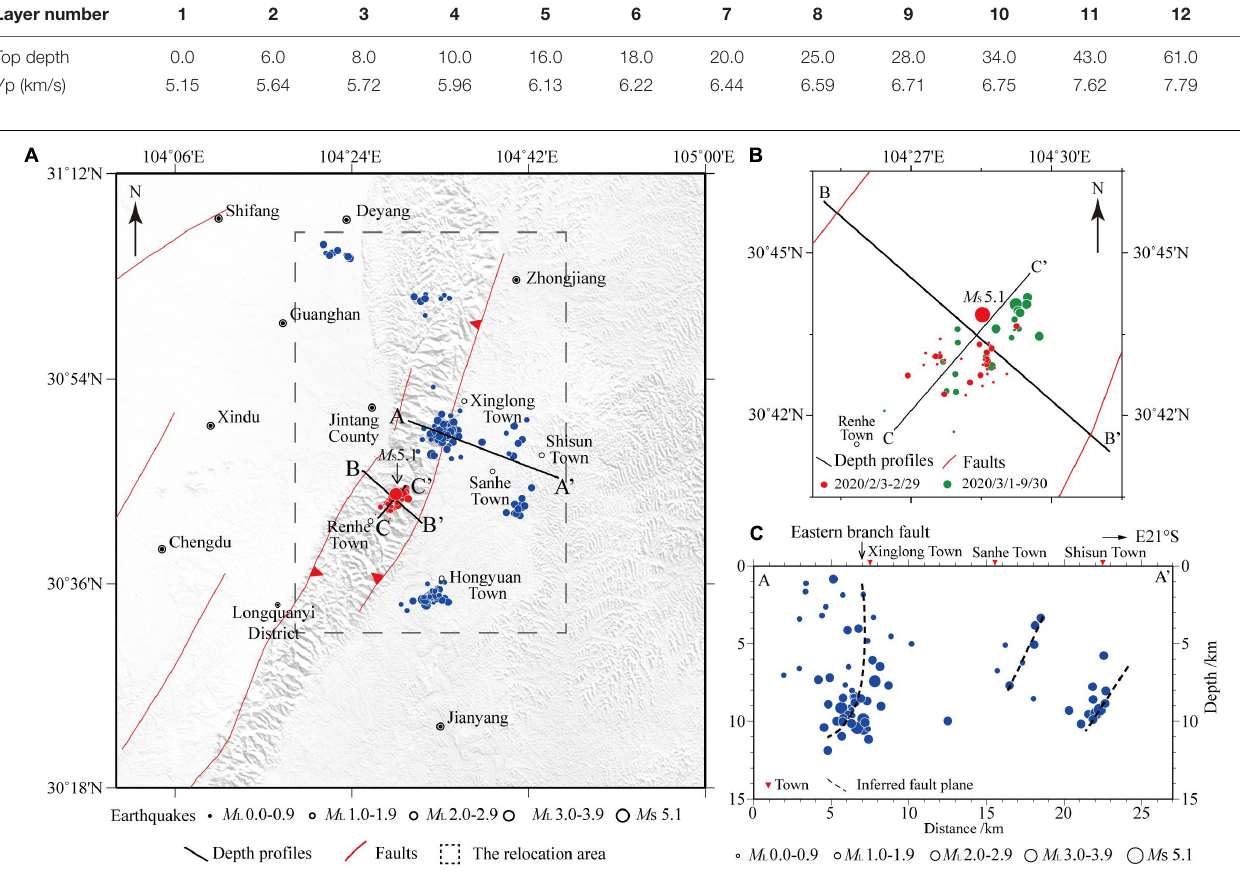
FIGURE 5 | Distribution of relocated epicenters. (A) Map of the relocated epicentral distribution across the central and northern segments of the Longquanshan fault zone since 2009; blue circles indicate the earthquakes since 2009, and red circles indicate the events in the 2020 M S 5.1 Qingbaijiang earthquake sequence. (B) Map of the relocated epicentral distribution of the M S 5.1 Qingbaijiang earthquake sequence. The aftershock distribution strikes NE–SW, with the M S 5.1 mainshock located in the northern part of the aftershock area. (C) Depth distribution of relocated events along the A–A’ profile. The three clusters appear to form a parallel imbricate feature consisting of three steep NW-dipping